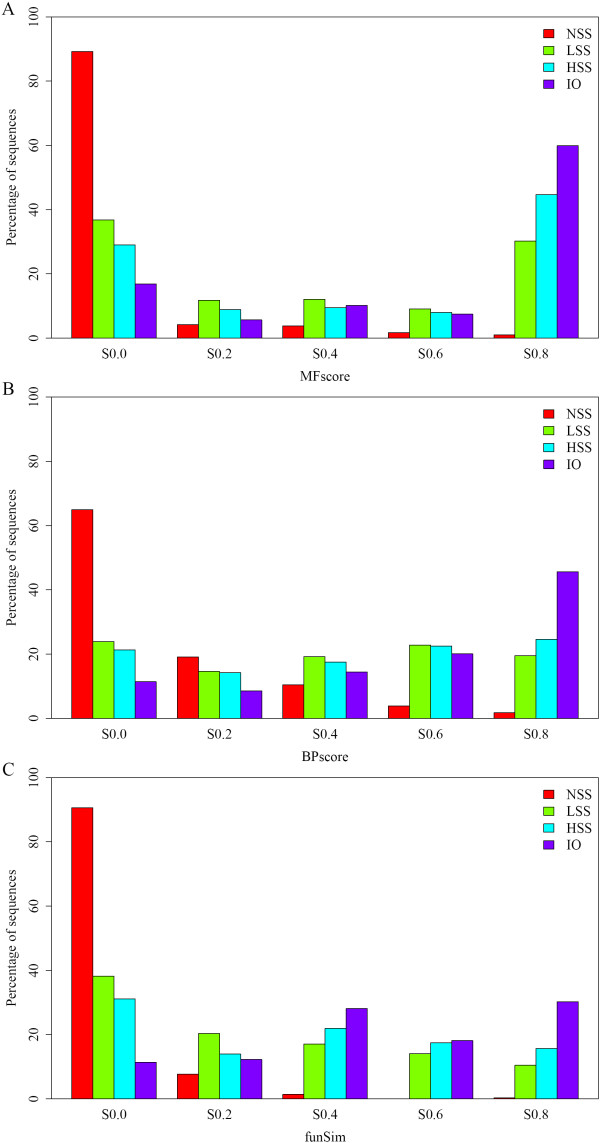
Distribution of the MFscore (A), BPscore (B), funSim score (C) for different sets of protein pairs excluding IEA and ISS annotation. The bins correspond to the following intervals of funSim values: S0.0: [0.0, 0.2[; S0.2: [0.2, 0.4[; S0.4: [0.4, 0.6[; S0.6: [0.6, 0.8[; S0.8: [0.8, 1.0]. The percentage values are calculated according to the total number of protein pairs in the different categories. The sets of the different categories contain the following numbers of protein pairs: NSS 288, LSS 364, HSS 338, and IO 563. The distributions were calculated by excluding all proteins with GO annotations with the evidence code IEA (inferred from electronic annotation) and ISS (inferred from sequence or structural similarity) from the datasets.